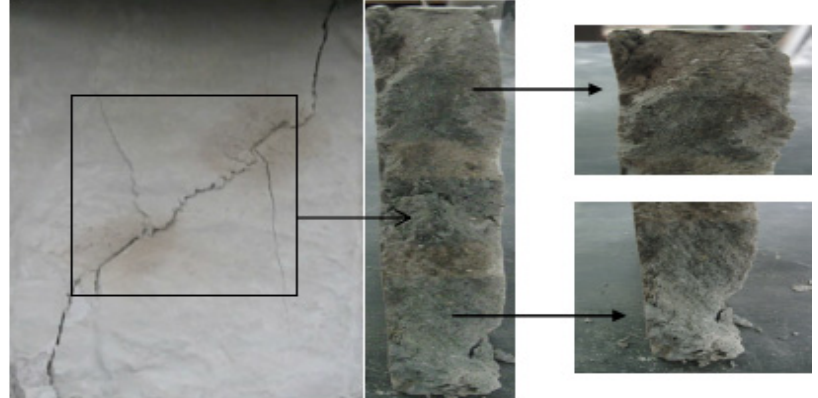
Figure 5. Second crack shear failure and its pattern.